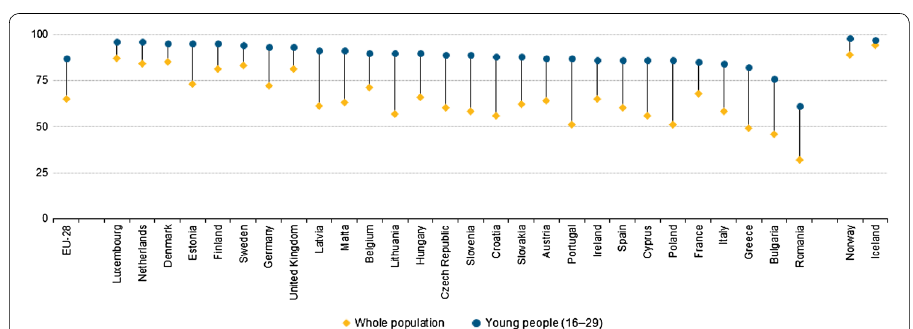
Fig. 3 Proportion of people who used a computer on a daily basis, 2014 (%). Source: Eurostat